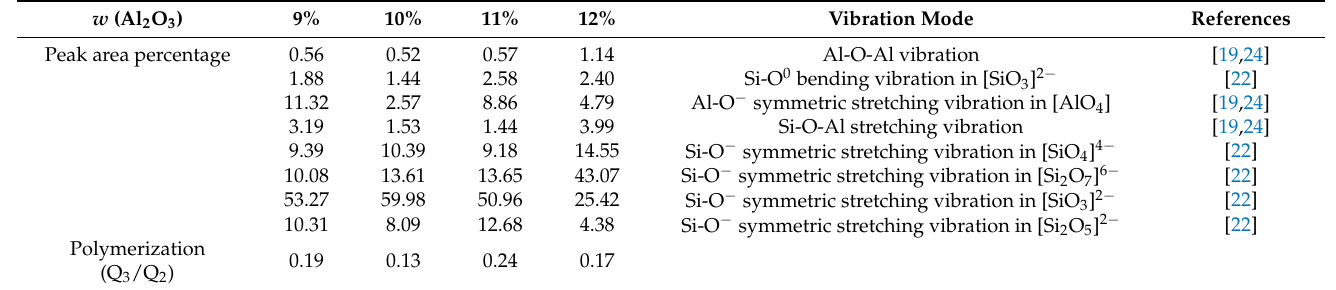
Table 7. Relative contents of the characteristic peaks of glass phases, with different Al 2 O 3